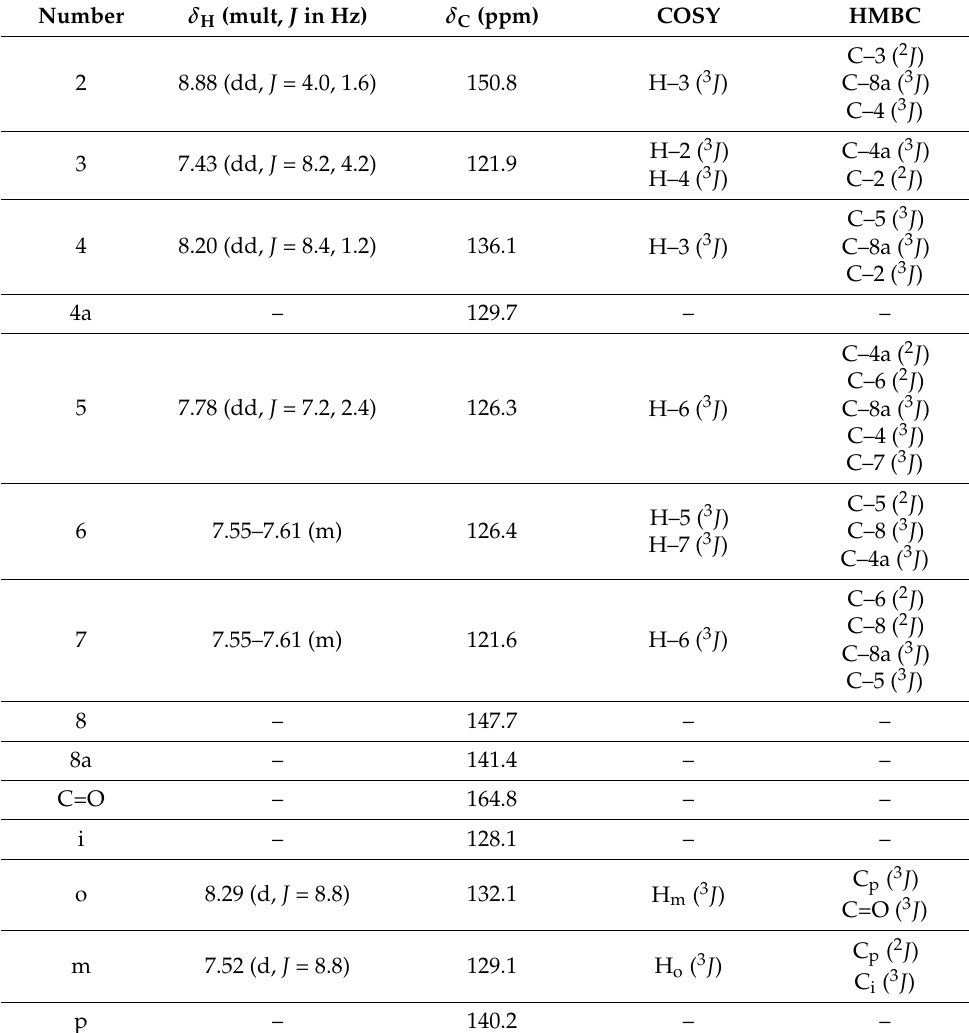
Figure 2. ( A ) Structure of compound 3 ; ( B ) Correlations of 3 based on COSY and HMBC experiments. Table 3. NMR assignments and correlations of compound 3 using 1D and 2D experiments.